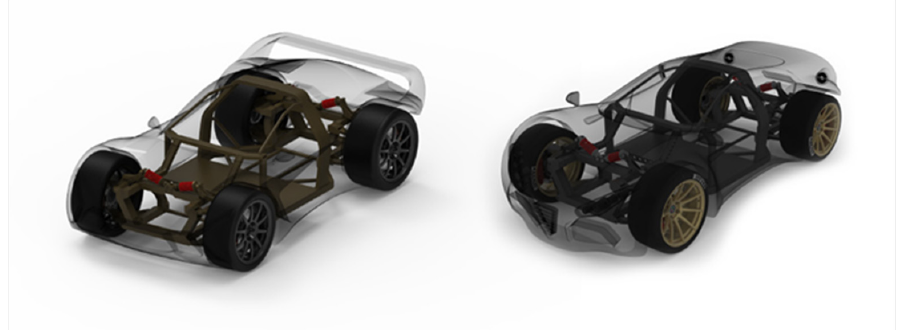
Figure 32. Car bodies showing the shared Chassis.